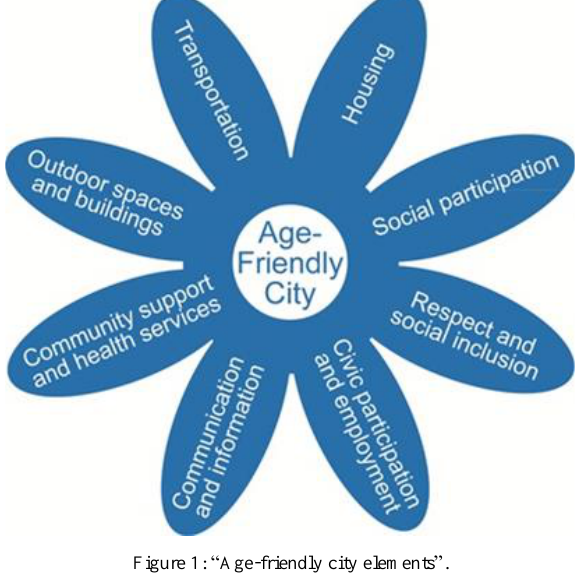
Figure 1: “Age-friendly city elements”. “World Health Organization,